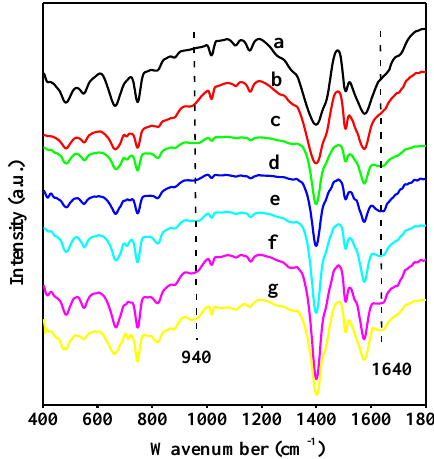
Figure 2. Fourier transform infrared (FTIR) spectra of various samples: (a) UiO-66; (b) 40 wt % WO 3 /UiO-66; (c) 5 wt % B 2 O 3 -40 wt % WO 3 ; (d) 10 wt % B 2 O 3 -40 wt % WO 3 ; (e) 15 wt % B 2 O 3 -40 wt % WO 3 ; (f) 20 wt % B 2 O 3 -40 wt % WO 3 /UiO-66; and, (g) 15 wt % B 2 O 3 -40 wt % WO 3 after the sixth reaction cycle.